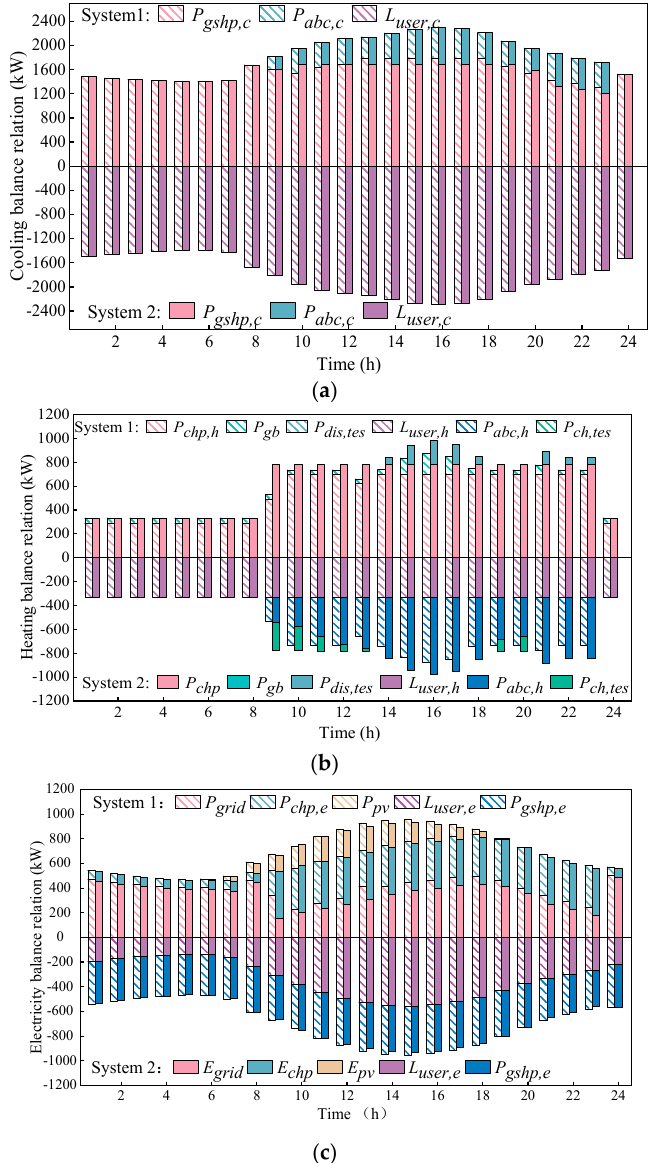
Figure 7. Scheduling process of System 1 and System 2 in design conditions: ( a ) Cooling load; ( b ) Heating load; ( c ) Electric load.